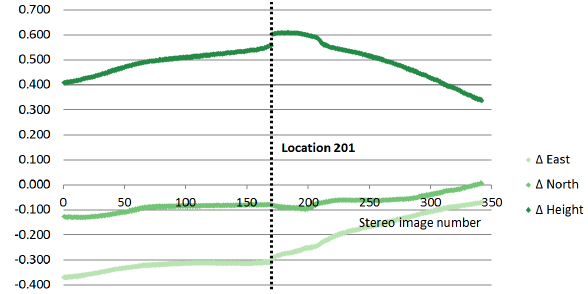
Figure 10. Deviations of projection centers for sequence 2.1